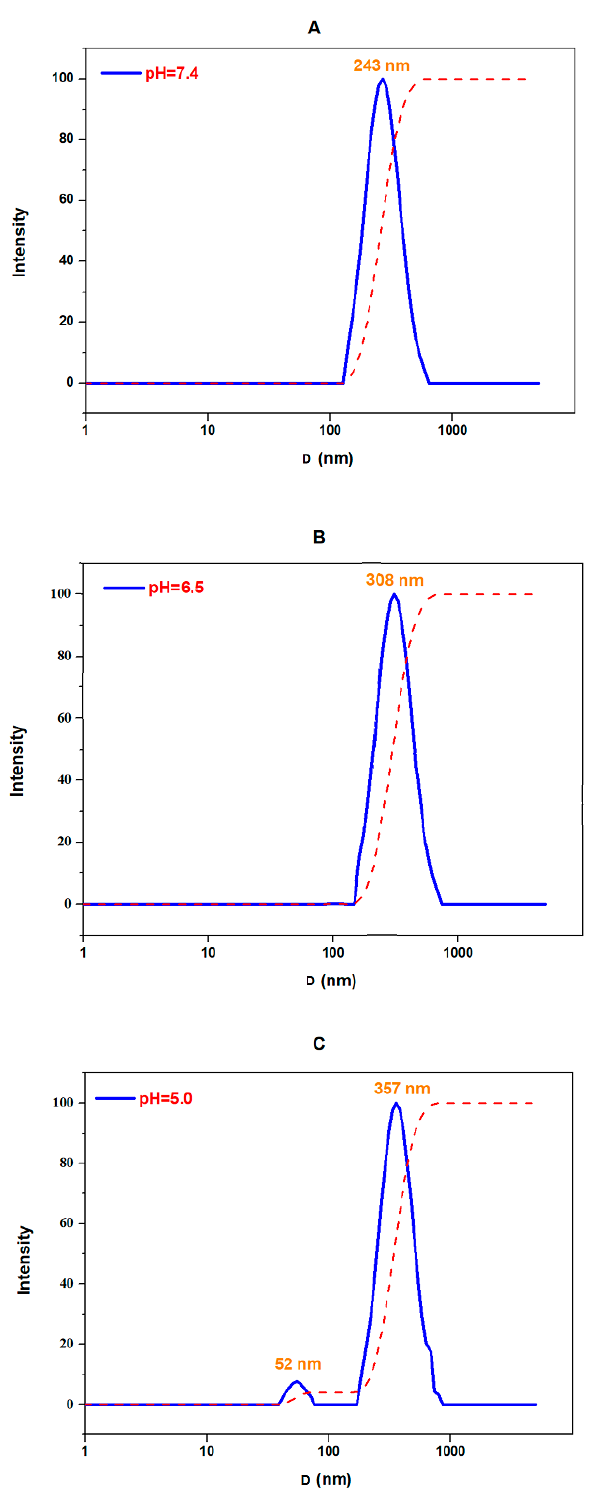
Figure 16. DLS I = f(r) diagrams of PLL 78 – b –(PLL 10 – g –PHIS 15 ) at: ( A ) pH = 7.4; ( B ) pH = 6.5; Figure 16. DLS I =f(r) diagrams of PLL 78 – b –(PLL 10 – g –PHIS 15 ) at: ( A ) p Η = 7.4; ( B ) pH = 6.5; ( C ) pH = ( C ) pH = 5.0 at 90 ◦ , 25 ◦ 5.0 at 90°, 25 °C.